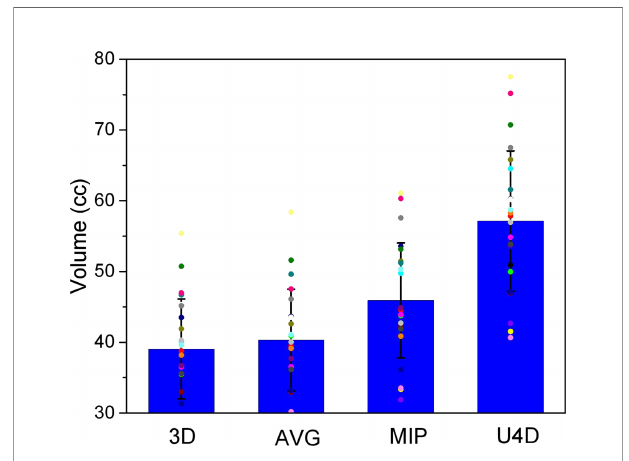
FIGURE 2 | The volume of the heart delineations for the 3-dimensional, average projection, and maximum intensity projection scans and the full extent of motion